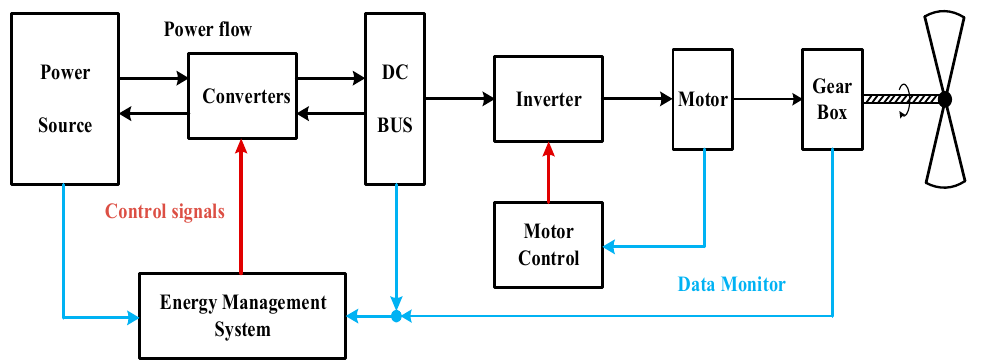
Figure 5. Composition of an electric propulsion system for UAVs.